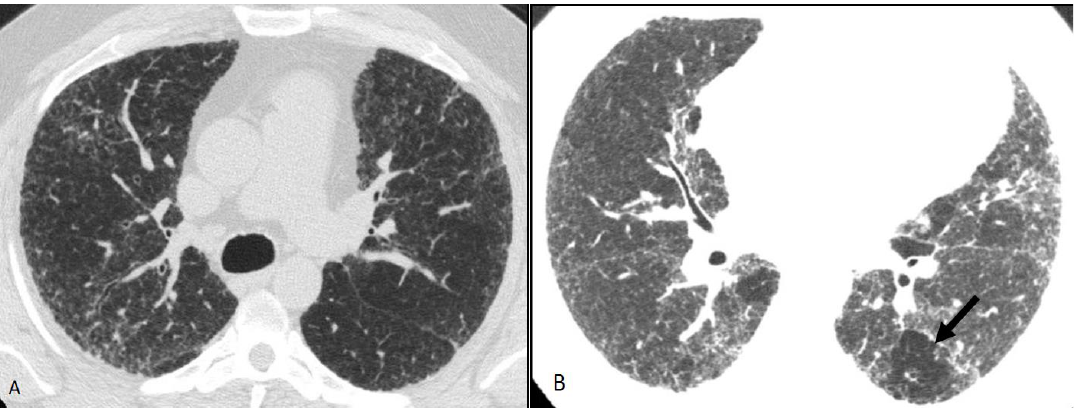
Figure 11. Compatible with fibrotic HP. Inspiratory phase CT ( top row ) shows ground glass opacities and subtle fibrosis. Note the variant upper lung predominant distribution. Expiratory phase CT ( bottom row ) shows air trapping (arrows).